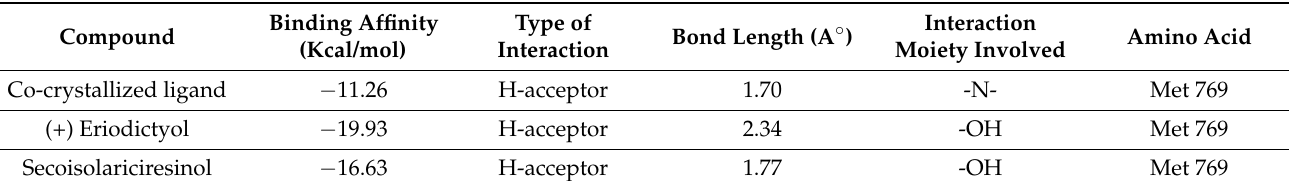
Table 4. Ligand–receptor interactions of (+) eriodictyol and secoisolariciresinol toward EGFR binding site.